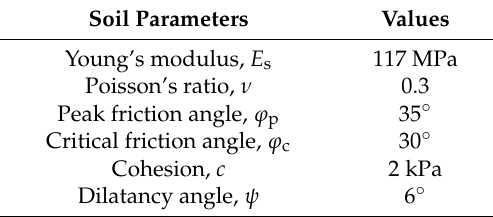
Table 1. Soil parameters used in the Mohr–Coulomb